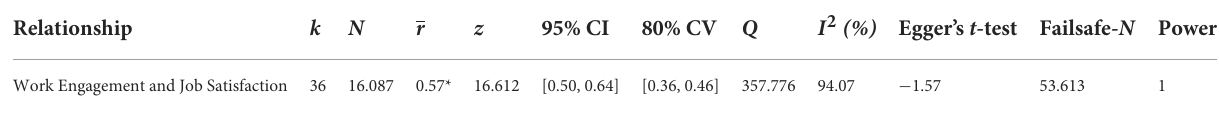
FIGURE4 (A,B) Funnel plots.